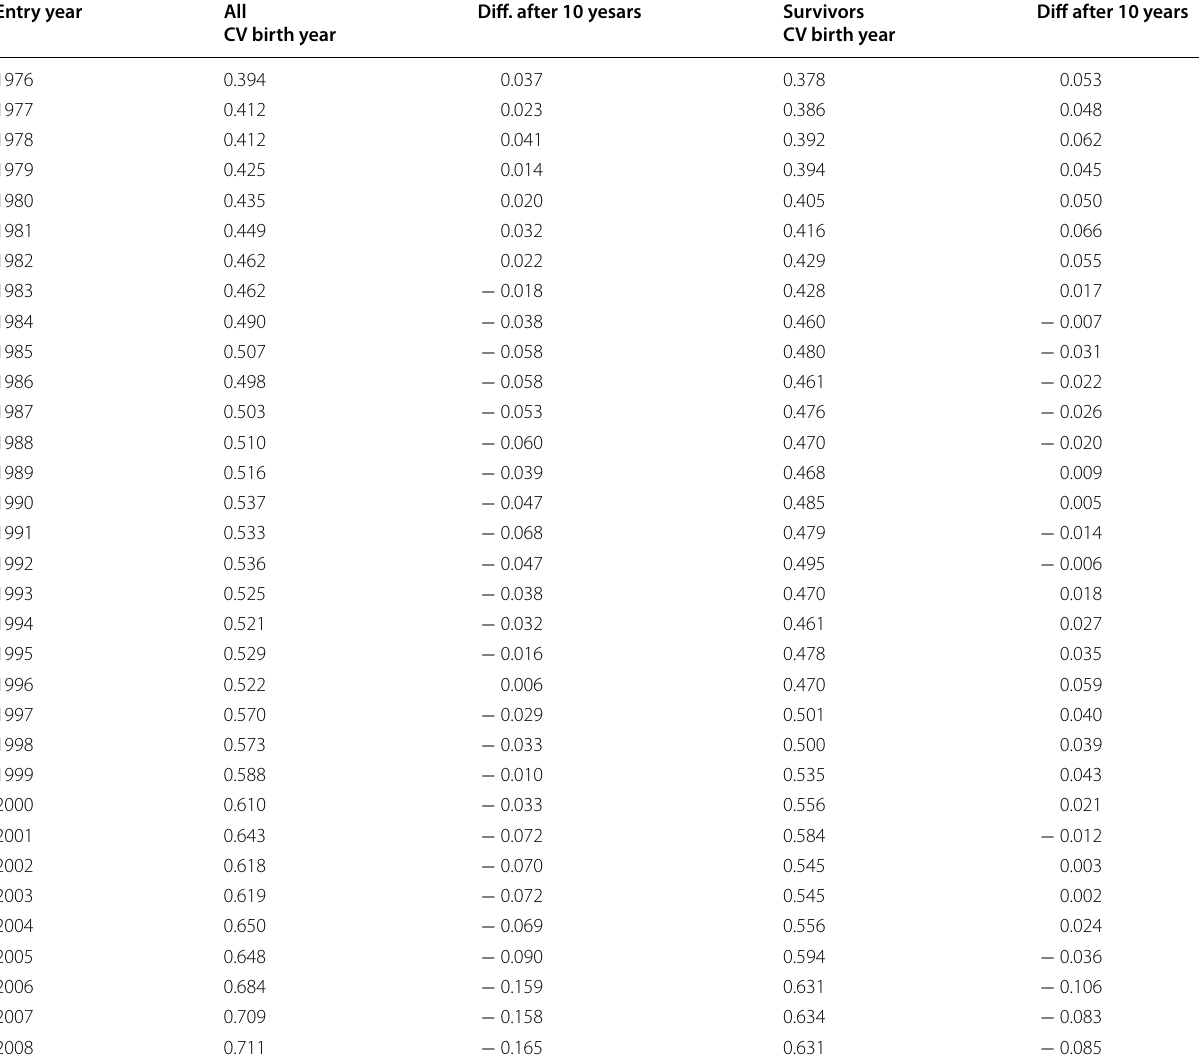
Table 7 Coefficient of variation in the birth year and the difference after 10